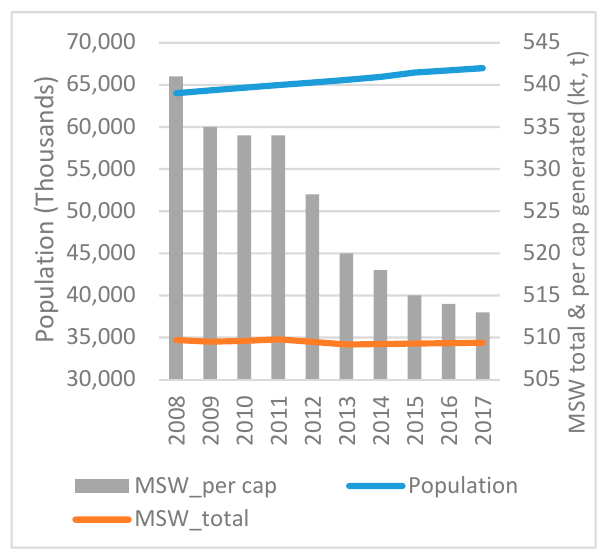
Figure 19. Population and MSW production in France 2008–2017 (European Statistics 2019a, 2019c).